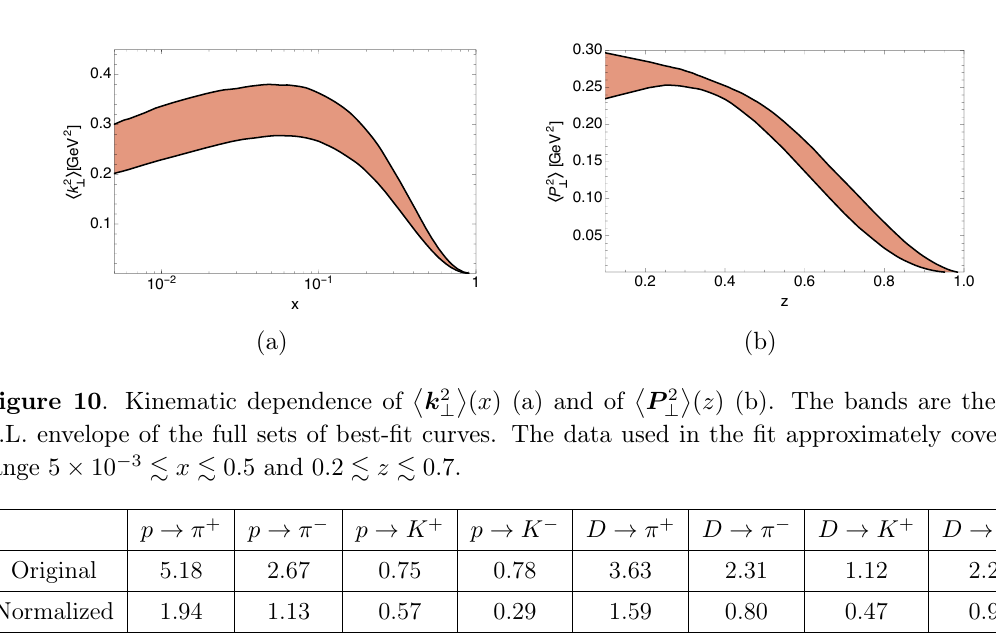
Table 12 . (cid:31) 2 /d.o.f. for Hermes data with and without normalization to the value of the first bin in P hT .